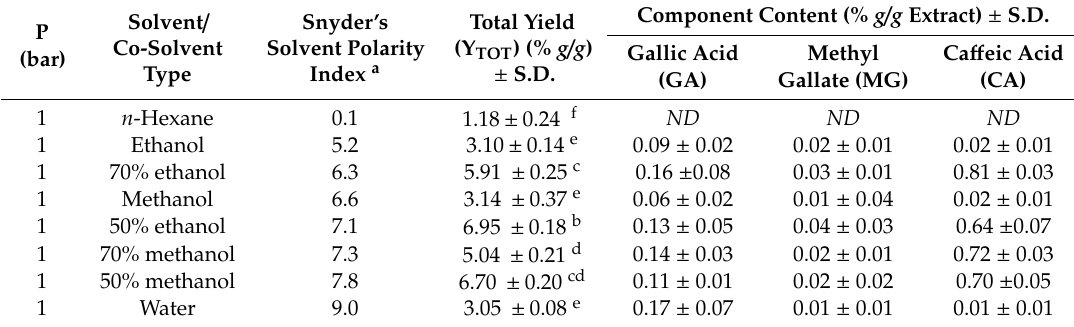
Table 1. Total yield and component composition of cold maceration of Labisia pumila leaf